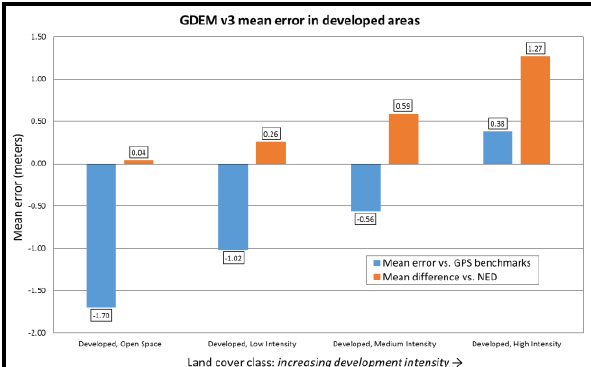
Figure 7. Increasing GDEM v3 mean error with increasing density of developed land